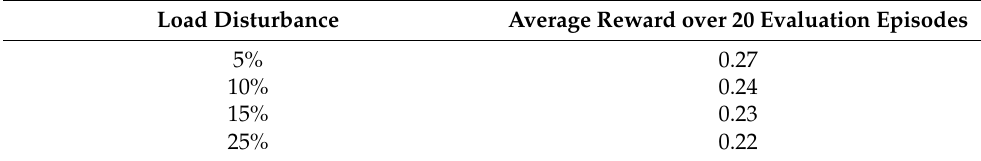
( b ) ( c ) Figure 6. Calculated operating parameters plotted on the graph of the modified IEEE 34-bus feeder for various simulation experiments. ( a ) Normal operating condition; ( b ) heavy load condition (non- control); ( c ) heavy load condition (secondary QU control).